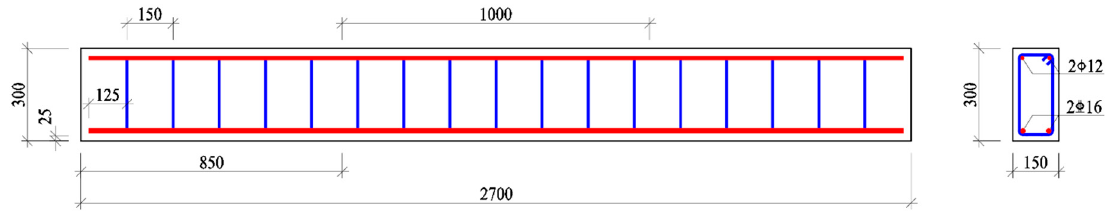
Figure 1. Details of the test beams.